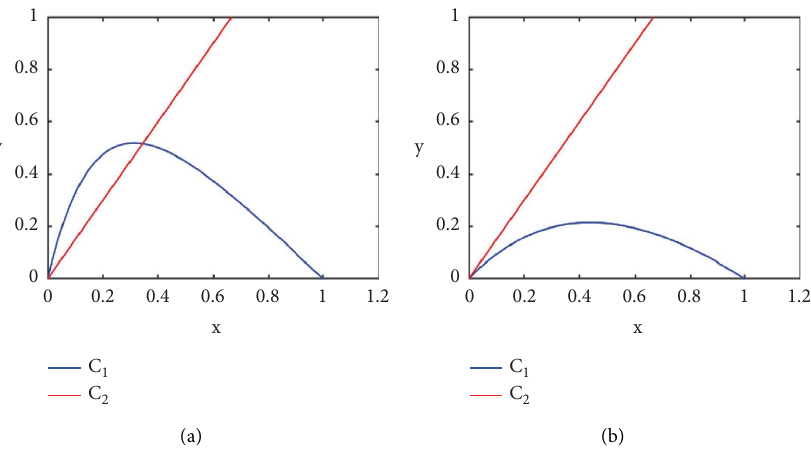
: F ( x ) � r ( 1 − x )( 1 − e − ε x ) , C : F ( x ) � ax ). 1 2